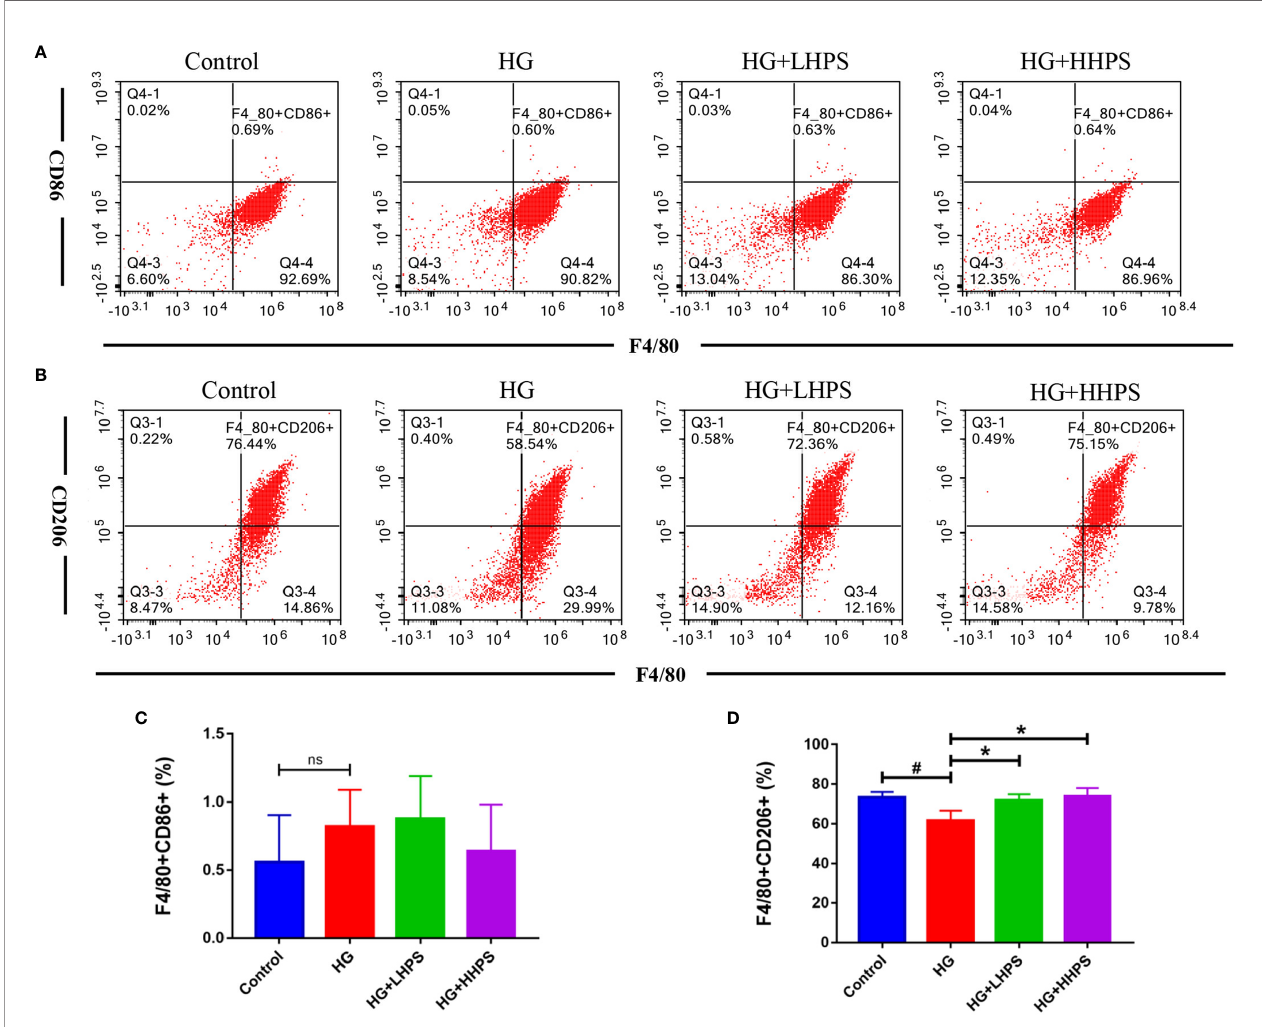
FIGURE 9 | Hyperoside promotes M2 macrophage polarization in high glucose (HG)-induced BMDMs in vitro. BMDMs were treated with high glucose (35mM) for 48 hrs, followed by pretreatment with high-dose HPS (HHPS) (50uM) or low-dose HPS (LHPS) (12.5uM), and then collected for fl ow cytometric analysis. The results showed that there was no signi fi cant difference in the proportion of F4/80 + /CD86 + macrophages between groups with or without Hyperoside treatment (A, C) . However, the proportion of F4/80 + /CD206 + macrophages was decreased in BMDMs with high glucose but increased after Hyperoside treatment (B, D) . Differences between experimental groups were evaluated using ANOVA ( # P < 0.05 vs Control; * P < 0.01 vs HG; ns, not signi fi cant). HG, high glucose treated group; HG+LHPS, high glucose and low dose of HPS treatment group; HG+HHPS, high glucose and high dose of HPS treatment